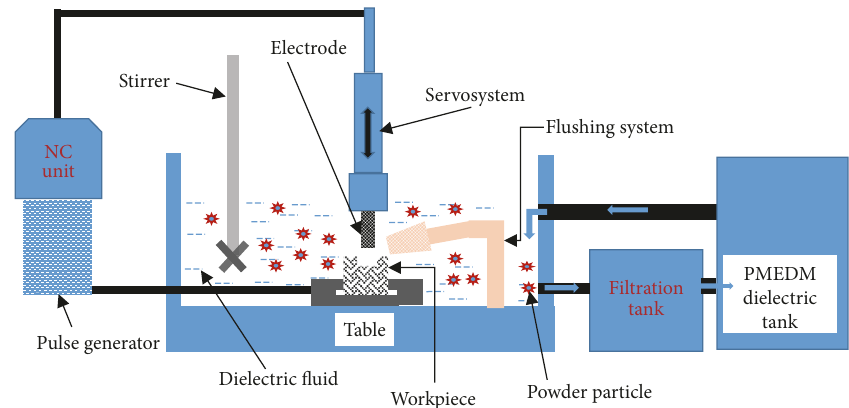
Figure 12: Schematic diagram of complete AM-EDM experimental setup.